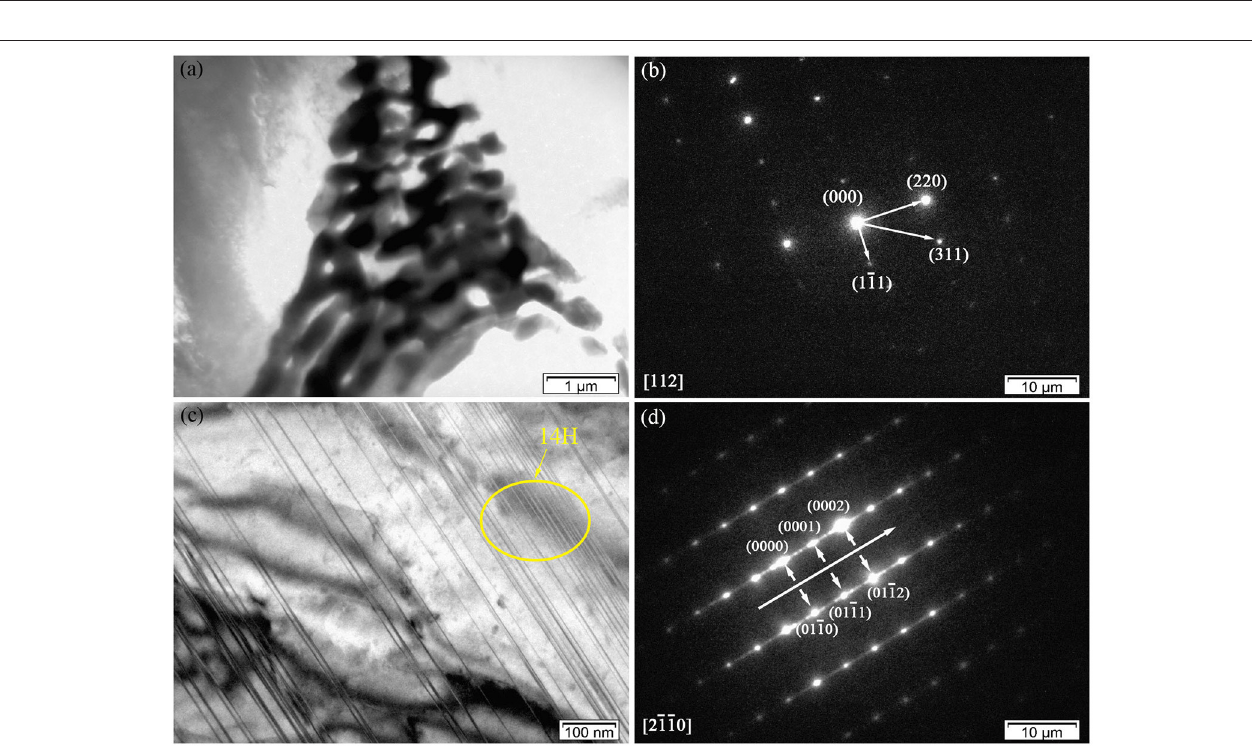
direction, which contains both the non-dynamic recrystallized (unDRXed) deformed grains and fine DRXed grains. Large grains own weaker texture. The bimodal-grained microstructure is commonly observed in extruded Mg alloys (Du et al.,